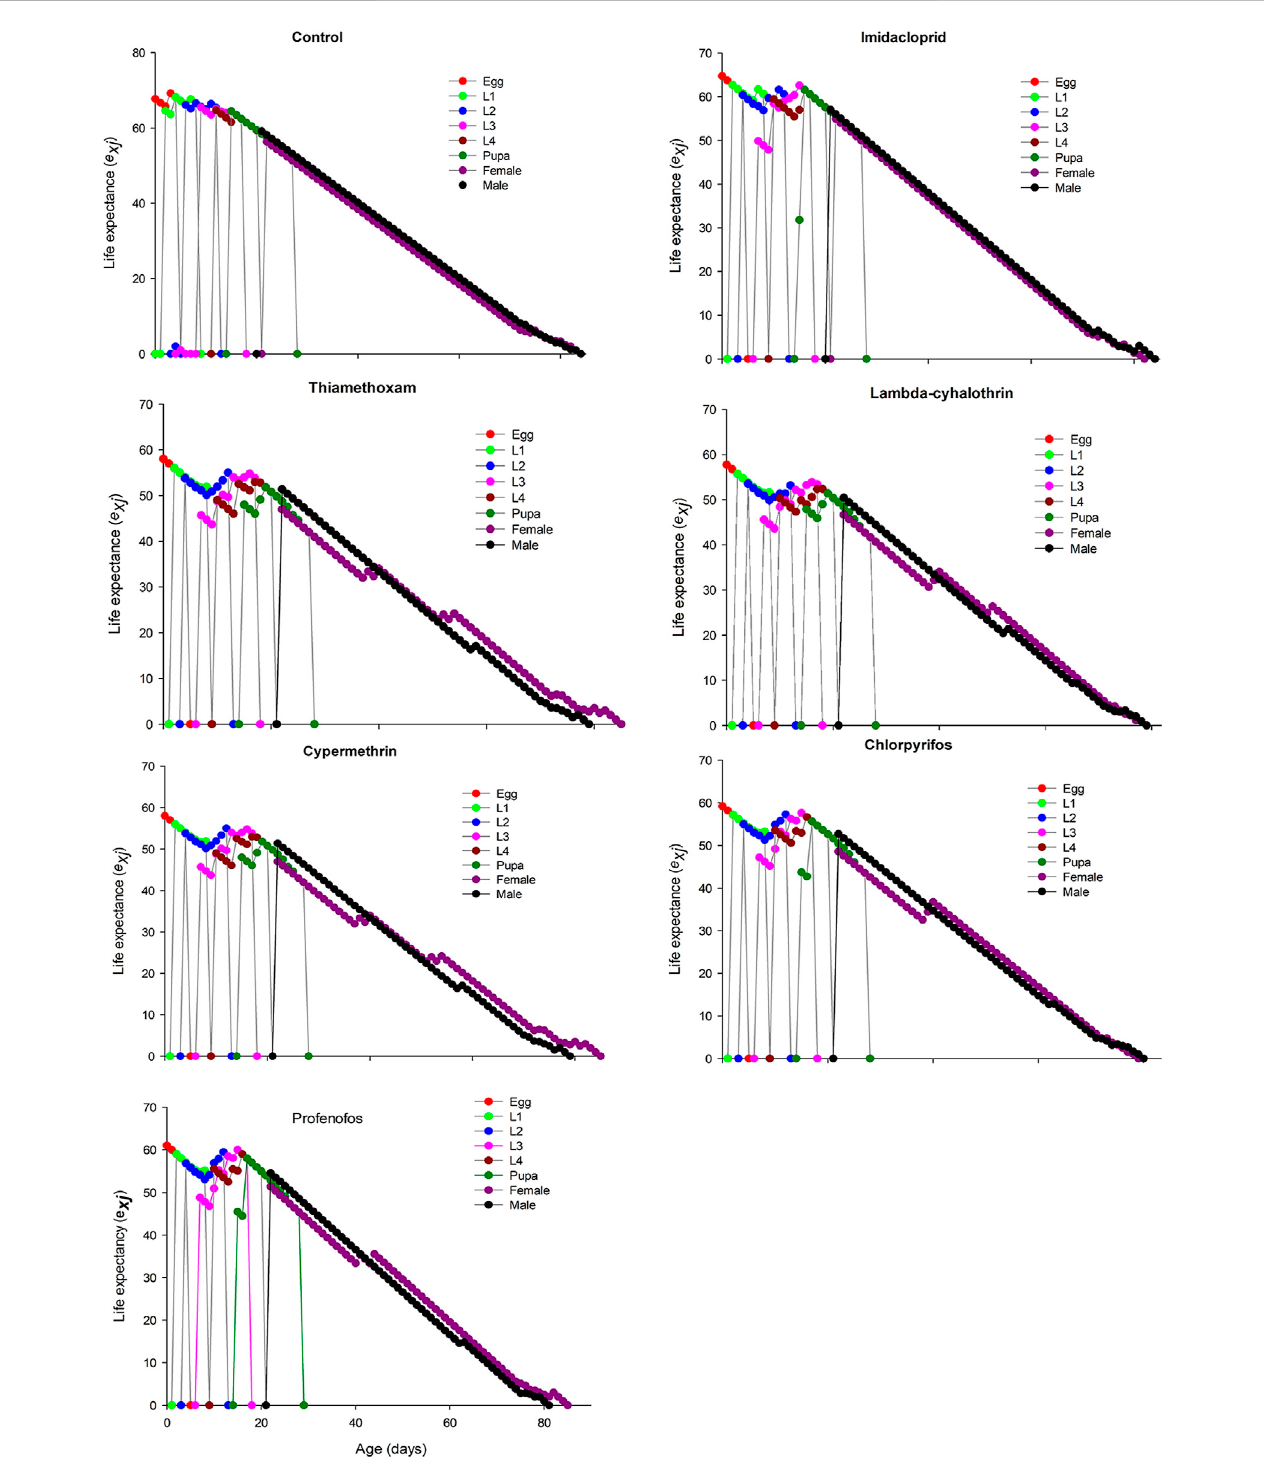
prolonged the third instar duration compared to the other three insecticides. All insecticides reduced the adult duration compared to the control treatment, and beetles treated with a sublethal dose of lambda-cyhalothrin had the least adult duration. The total longevity